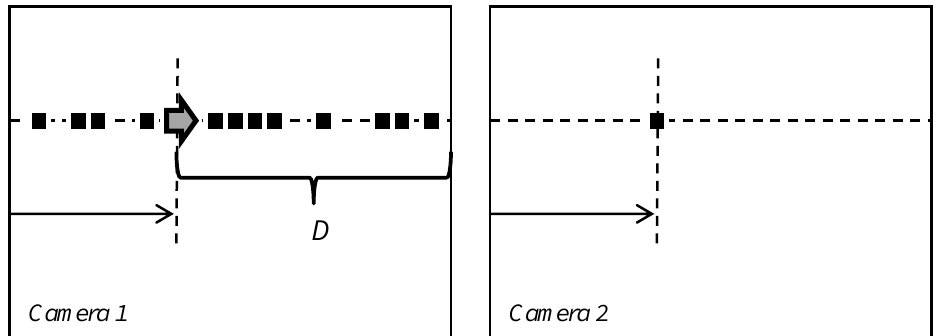
Figure 9. Range D available for